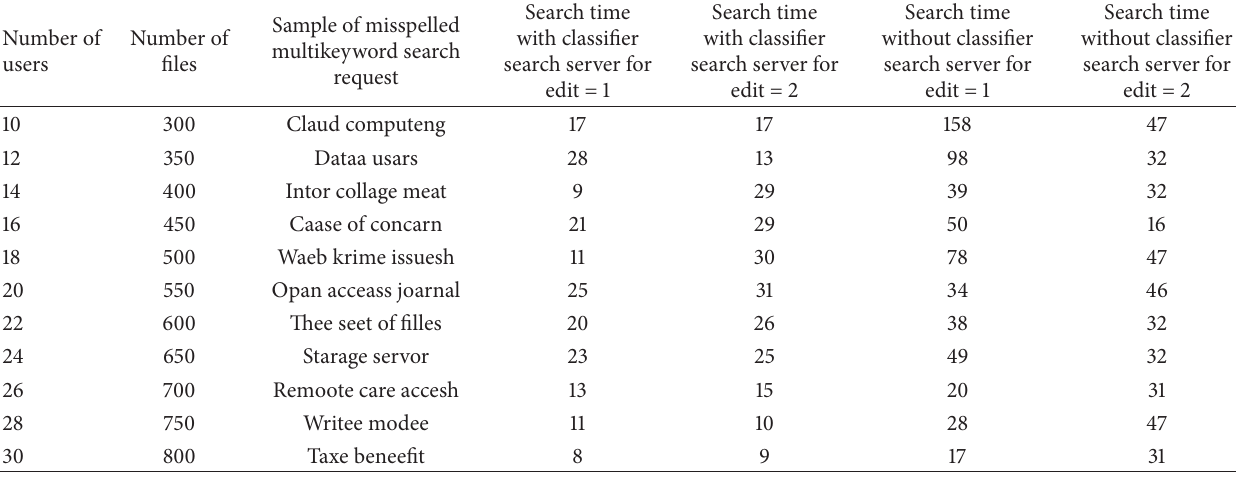
Table 5: Analysis of search efficiency for misspelled keywords with and without classifier search server.